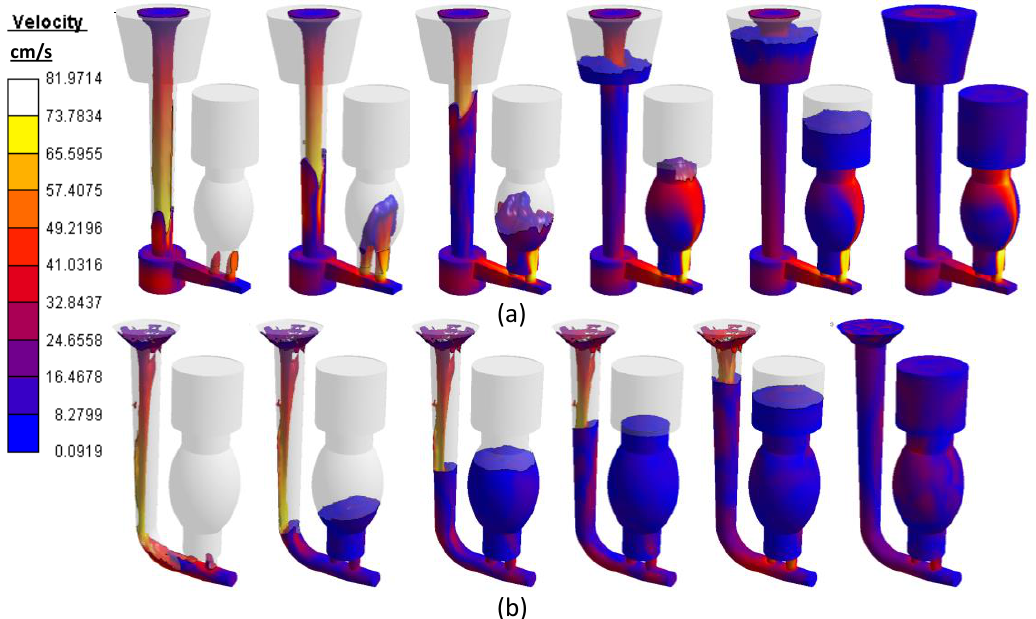
Figure 5. ( a ) Sand casting filling velocity profile, ( b ) 3DP filling velocity profile.